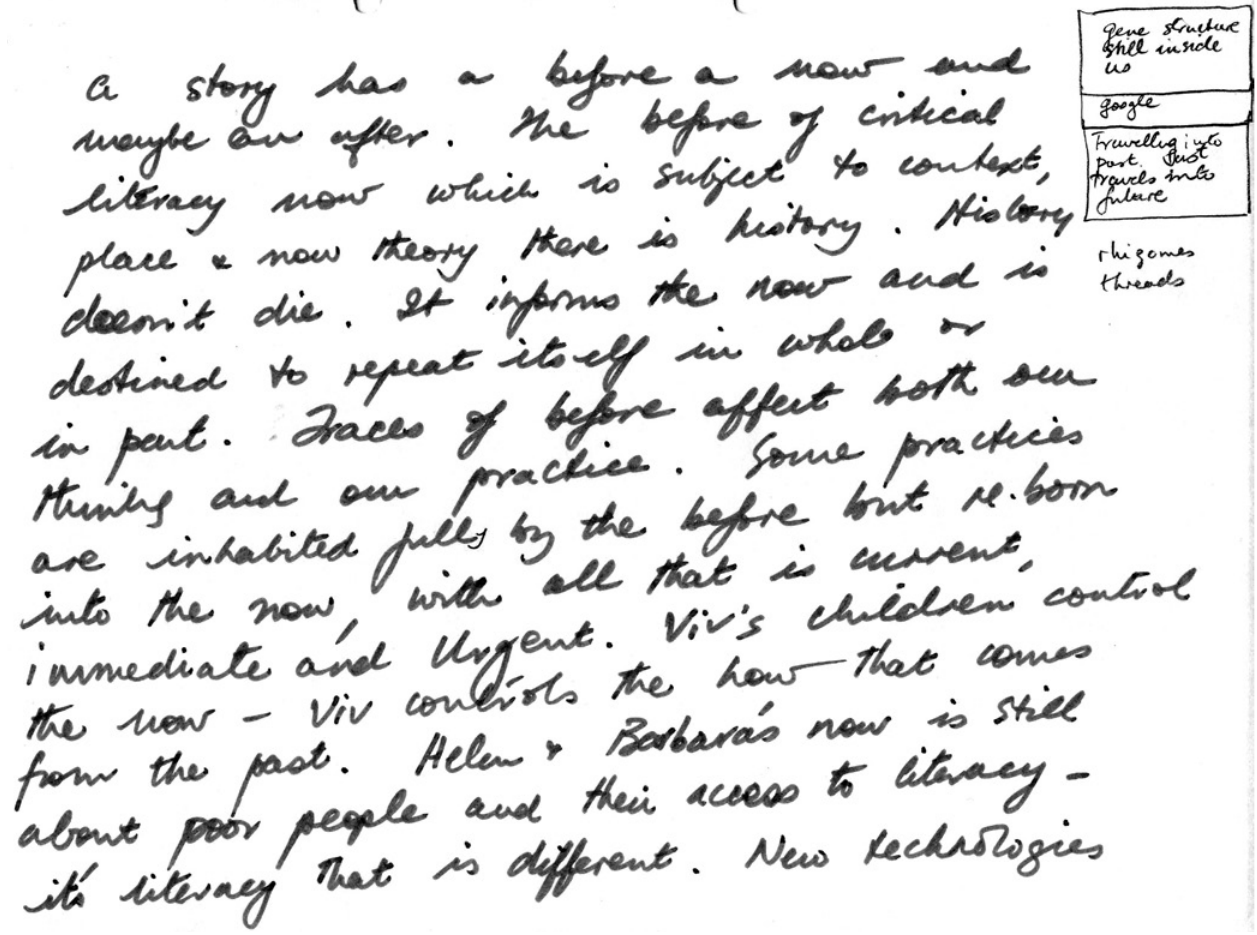
FIGURE 2: Writing that flowed from the free-writing activity on the word